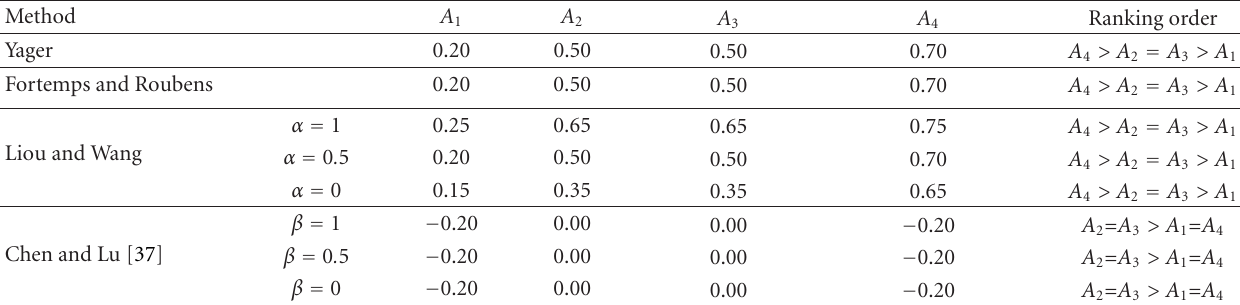
Table 1: Comparison of various ranking